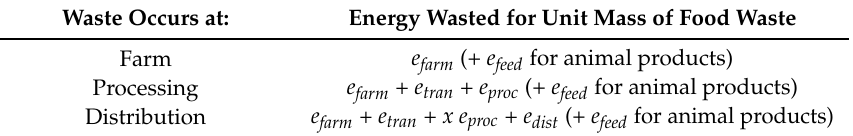
Table 4. Scheme for computing energy embodied in food waste. Source: Authors’ elaboration.